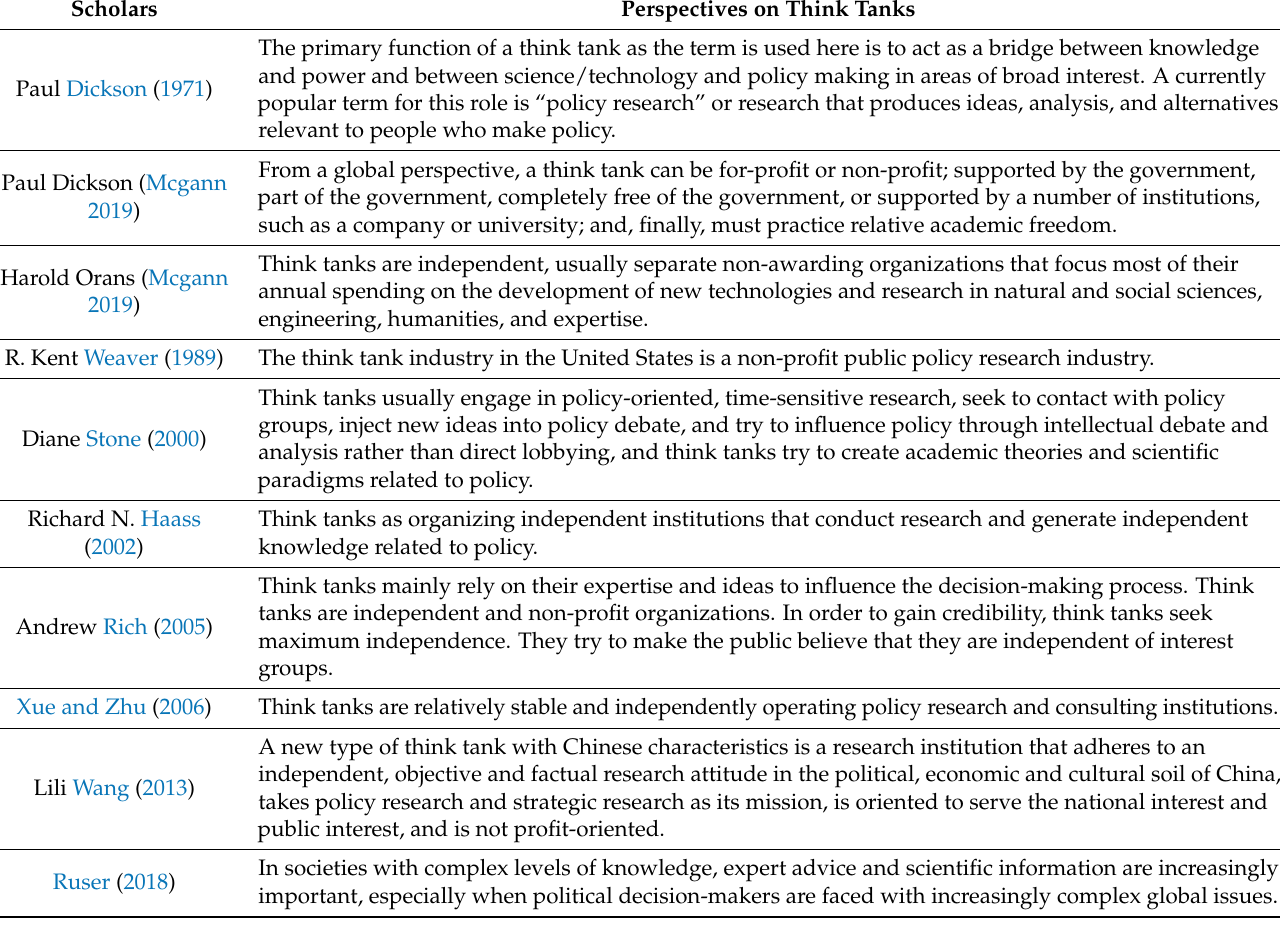
Table 1. Main views of important scholars on think